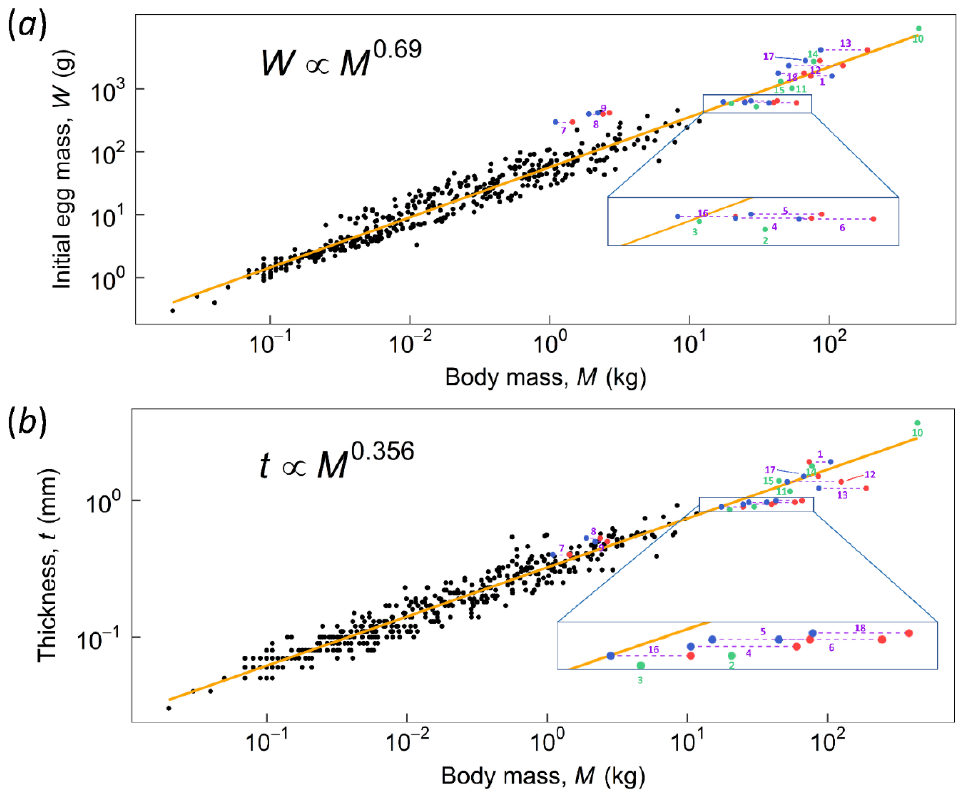
Figure 5. The regression line of ( a ) initial egg mass and ( b ) eggshell thickness on body mass. Data used to plot regression are from Juang et al. [3]. Green dots indicate species with no RSSD. Red dots (female) and blue dots (male) connected by dashed lines indicate species with RSSD. The numbers 1 to 18 represent different species, as denoted in Table 1.